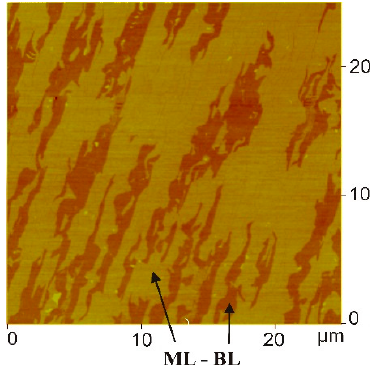
Figure 6. AFM phase image of monolayer and bilayer graphene on SiC (not published results).